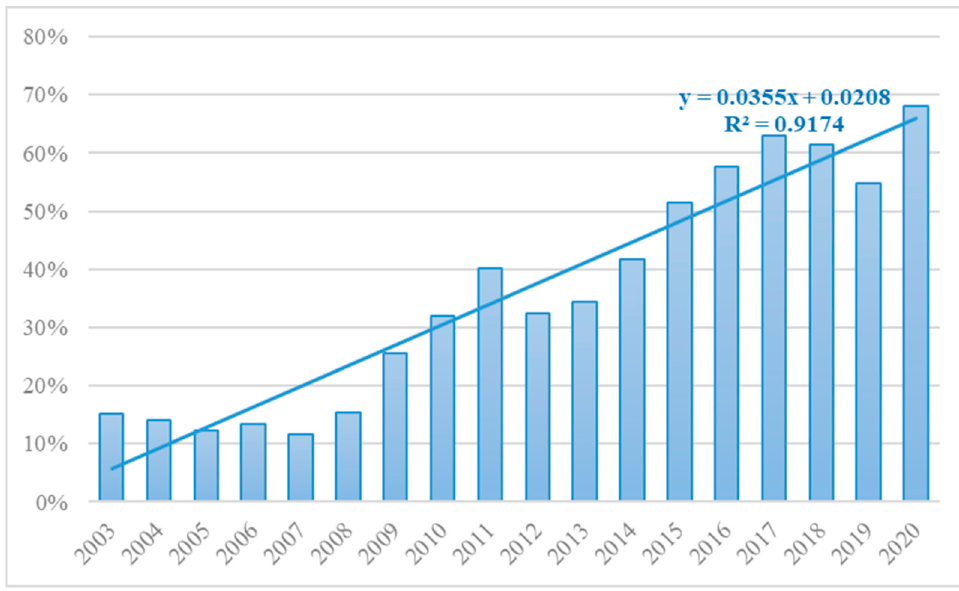
Figure 10. Ratio of liabilities to the annual budget revenues for 2003–2020 (in %) for the city of Zabrze. Source: own elaboration. Table 3. Statistics for the liabilities of the examined cities.